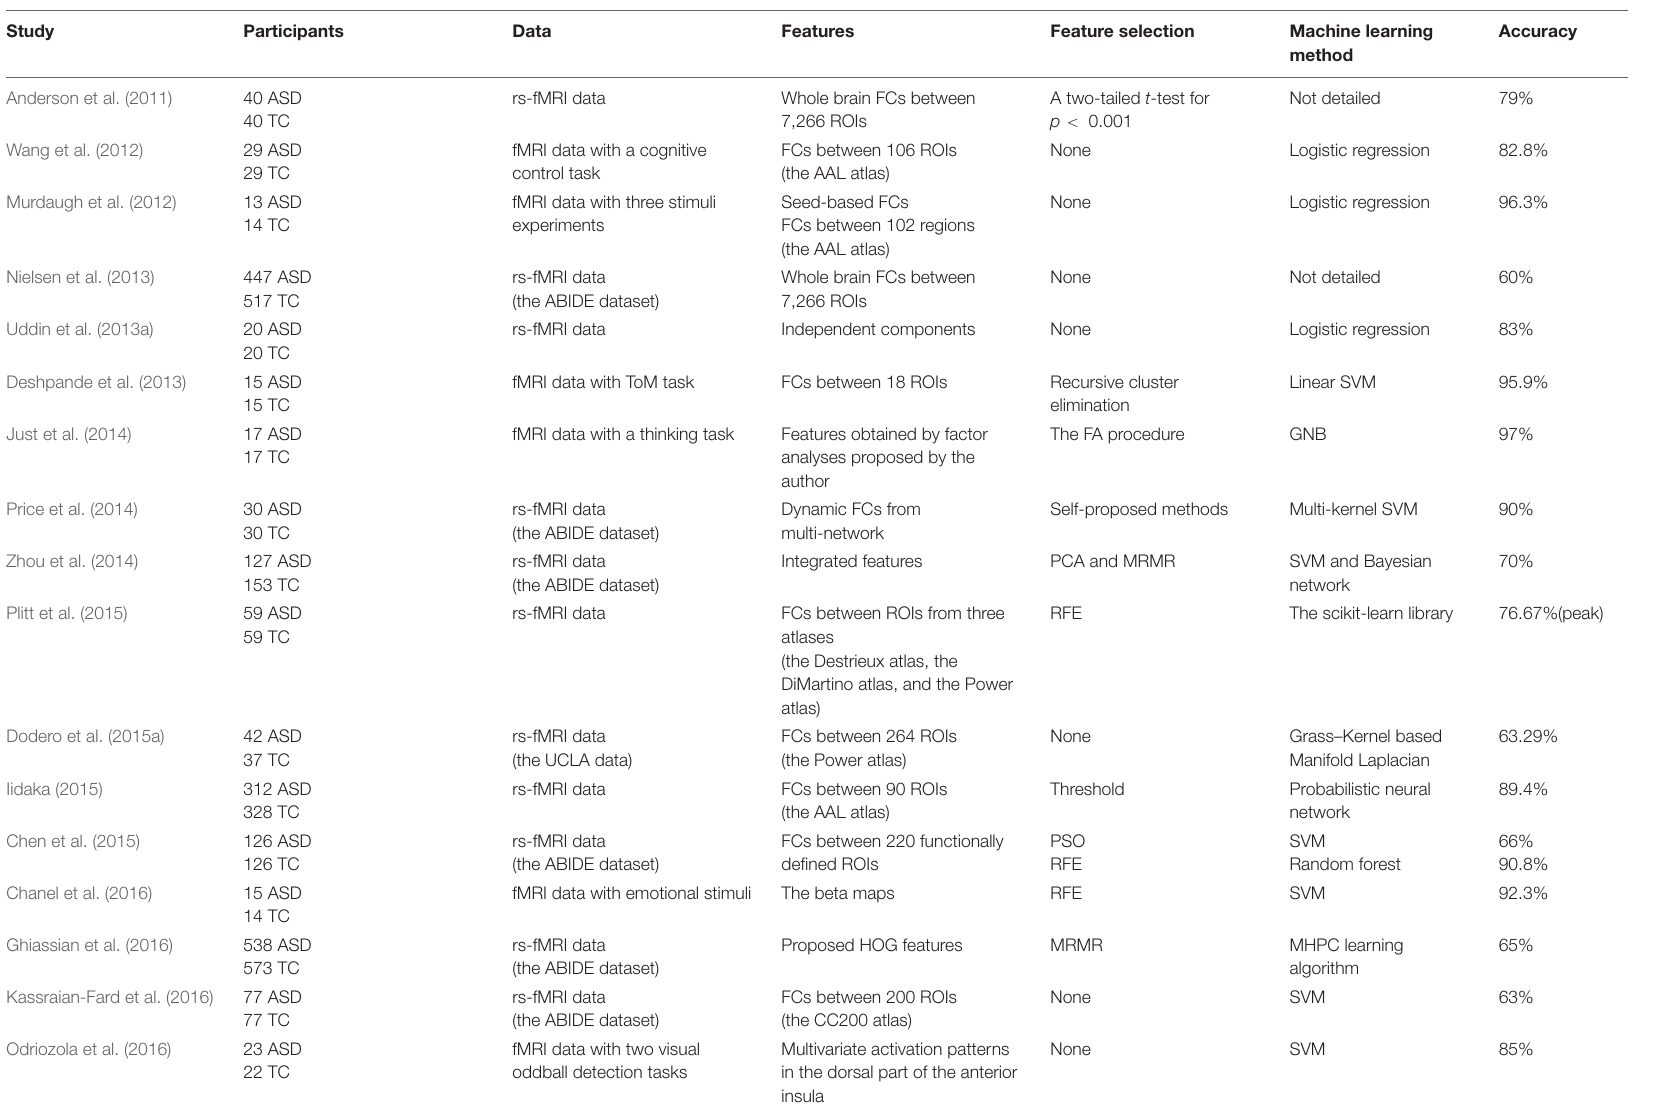
TABLE 1 | Summary of ASD classification studies based on fMRI